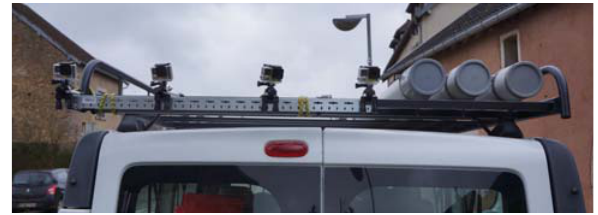
Fig. 9: Test mounting on another vehicle